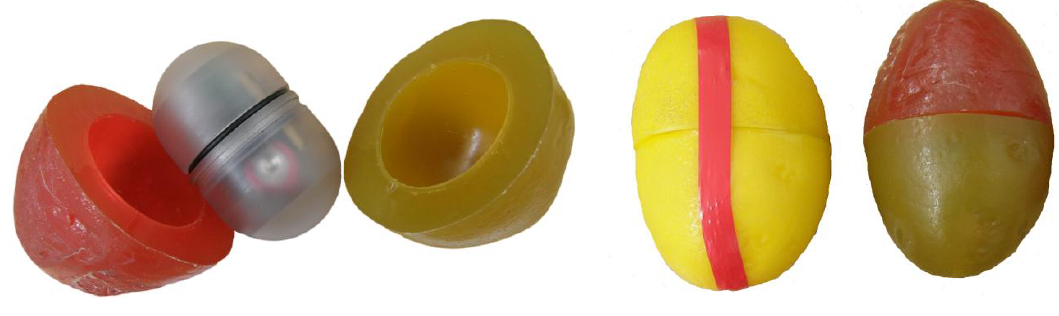
Figure 3. Smart Spud sensor with original casing from the Sensor Wireless company (red-green) and casing from the Grimme company (yellow).